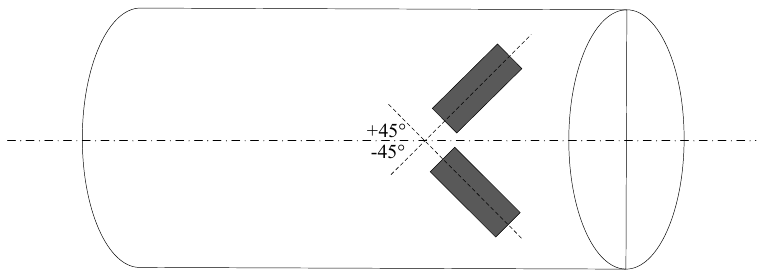
Figure 2. The schematic of the surface acoustic wave (SAW) torque sensor structure.